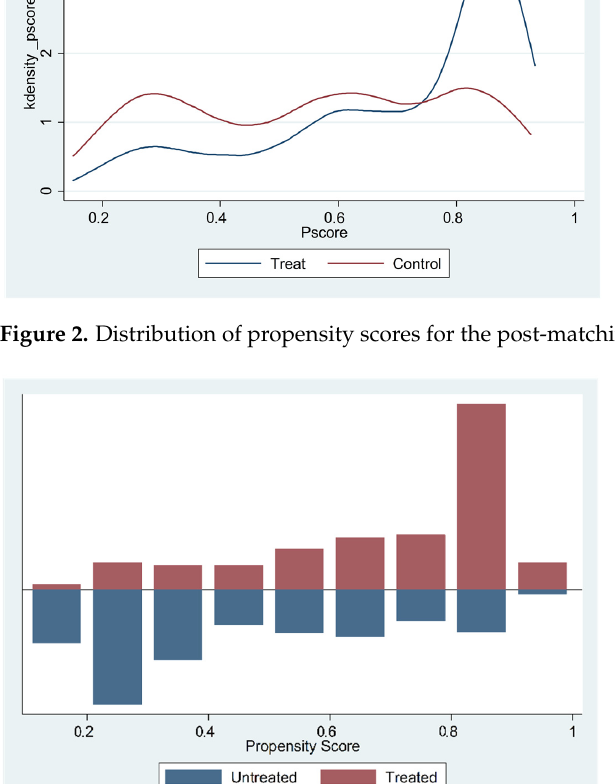
Figure 2. Distribution of propensity scores for the post-matching treatment and control groups.